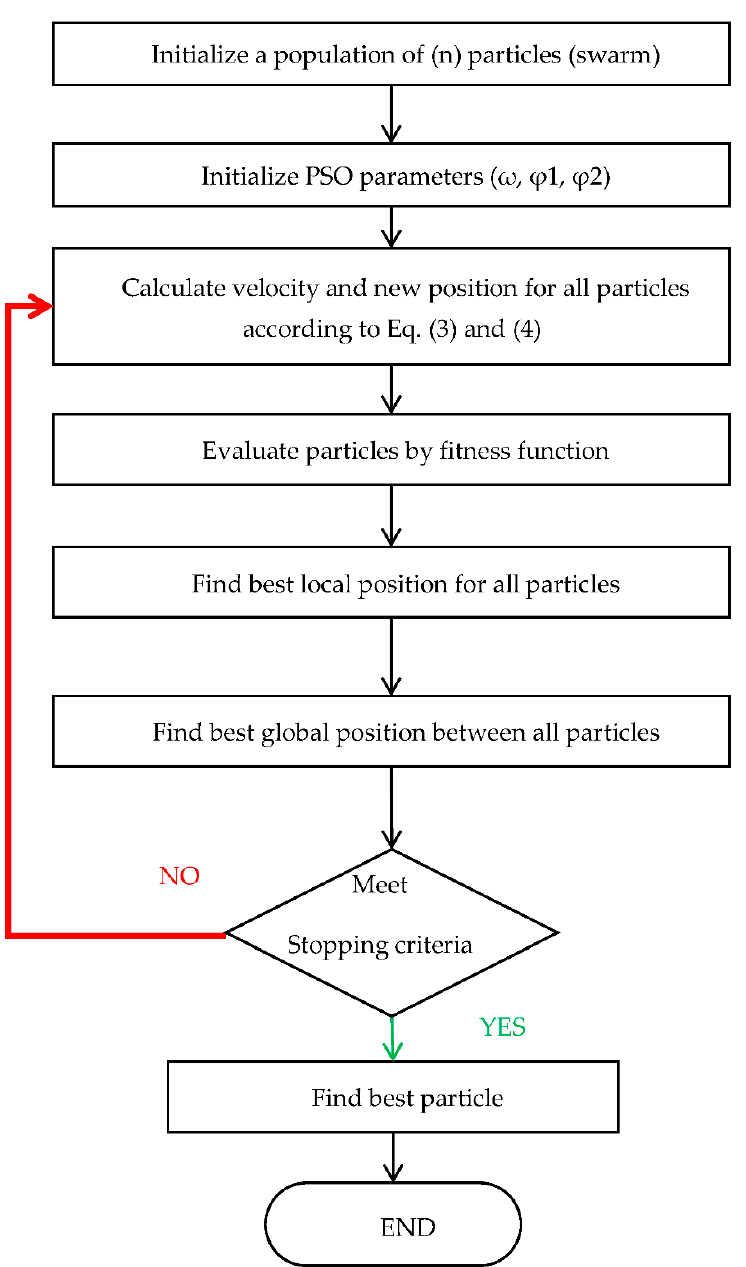
Figure 2. Flowchart of Particle Swarm Optimization (PSO).